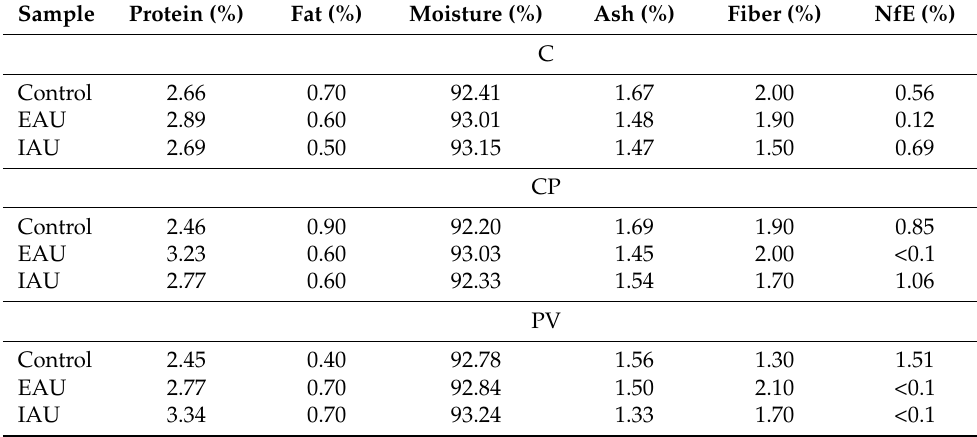
Different superscript letters within a row indicate statistically different mean values at p < 0.05. Table 8. Wheatgrass gross nutrient contents in different experimental groups (“Control”—fertilized tap water; “IAU”—fish effluents from intensive aquaculture unit; “EAU”—fish effluents from exten- sive aquaculture unit; “C”—100% coconut fibers; “CP”—70% coconut fibers + 30% perlite; “PV”—50% vermiculite + 50%